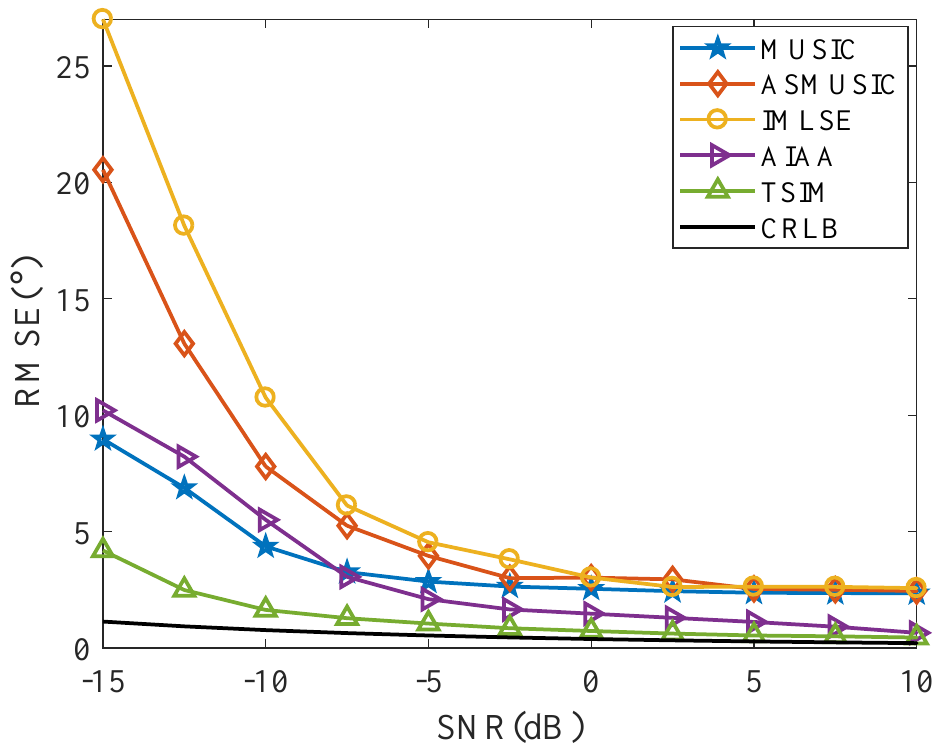
Figure 2. RMSE versus SNR with L = 300, µ = 15 m and σ = 4 under non-uniform